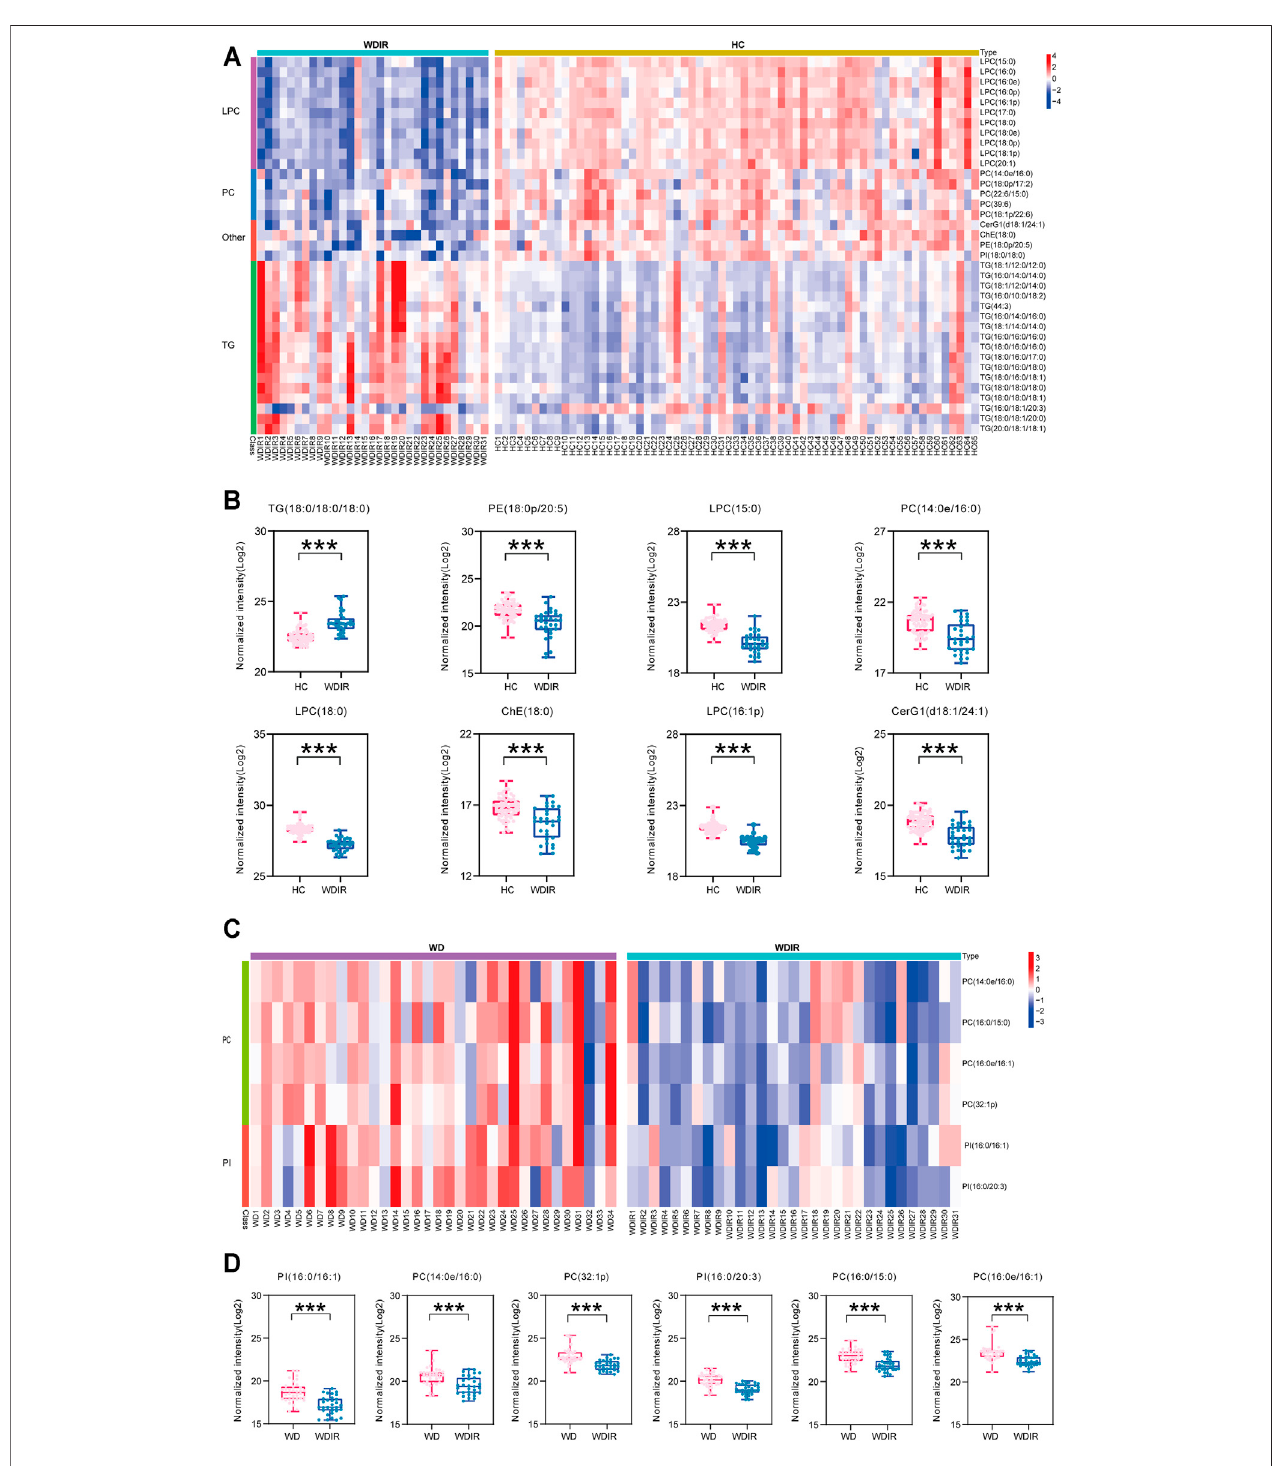
FIGURE4| Metabolomicpro fi lesdifferbetweenWDIRvsHCandWDvsWDIR. (A) Heatmapofthe37differentialmetabolitesbetweenWDIRandHC. (B) Relative concentration of differential metabolites screened by LASSO in WDIR and HC. (C) Heat map of the 6 differential metabolites between WD and WDIR. (D) Relative concentration of differential metabolites in WD and